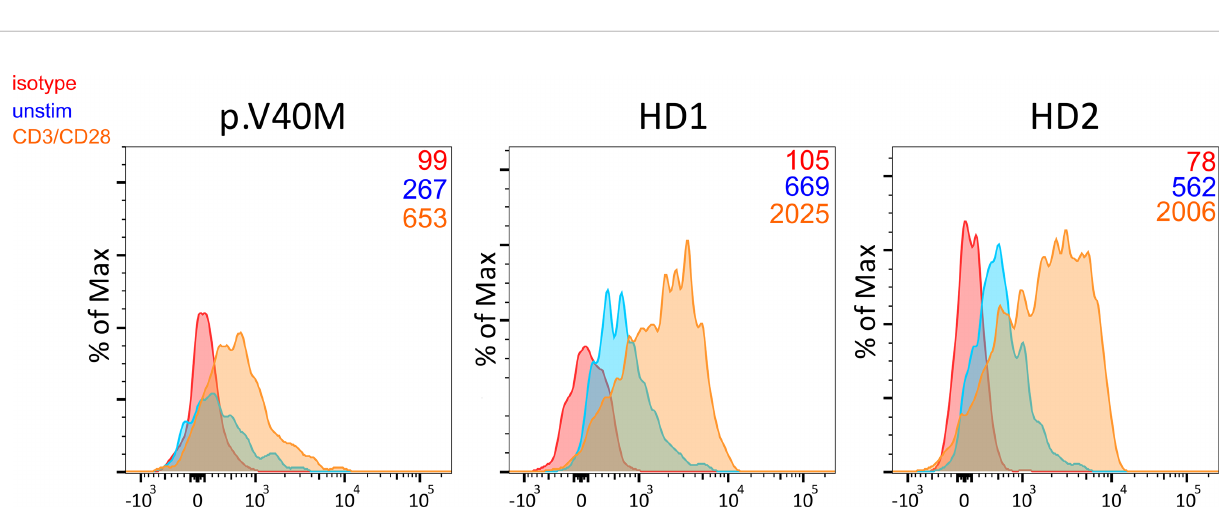
FIGURE 4 | Decreased baseline and CD3/CD28 activation-induced CTLA-4 expression in CD4 + CD25 hi CD127 lo Treg from a patient harboring the c.118G>A (p. V40M) variant in CTLA-4 and two healthy blood donors. Median fl uorescence intensity of CTLA-4 is shown (numbers) for each studied